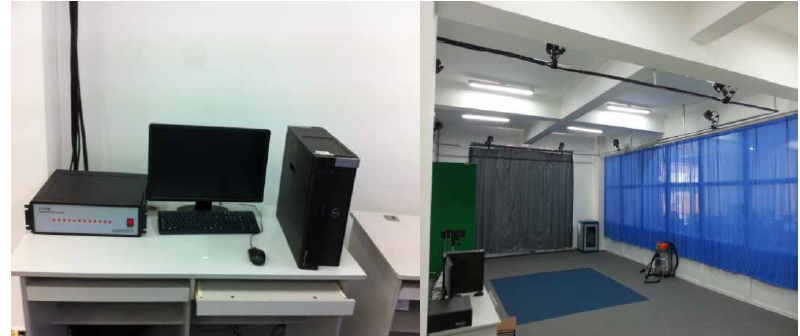
Fig. 2 Laboratory scene and main equipment.